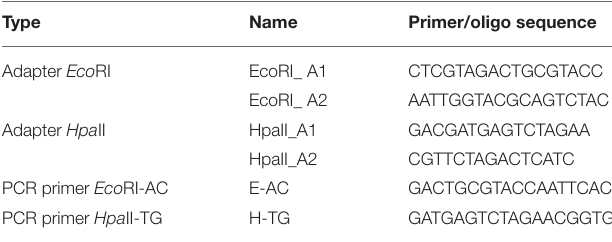
TABLE 1 | The sequences of the primers and adapters that were used for the MSAP-Seq analyses.